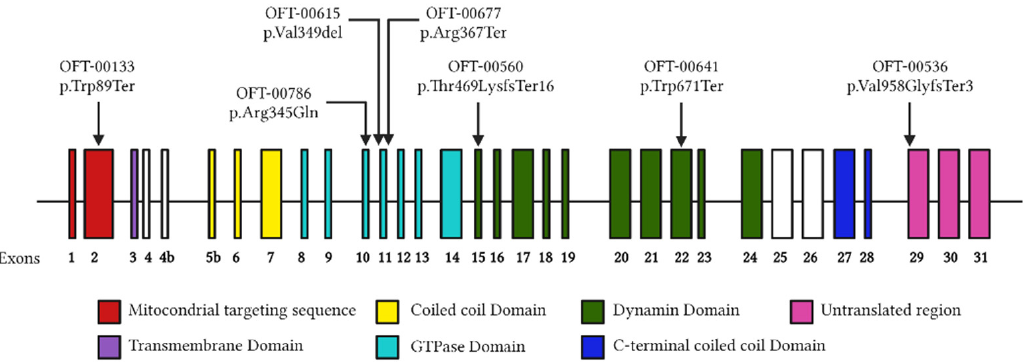
Figure 2. Distribution of OPA1 variants. Each distinct variant observed in our cohort is represented above the respective exon. The structural domains of the protein encoded by each exon are detailed with different colors, respectively.